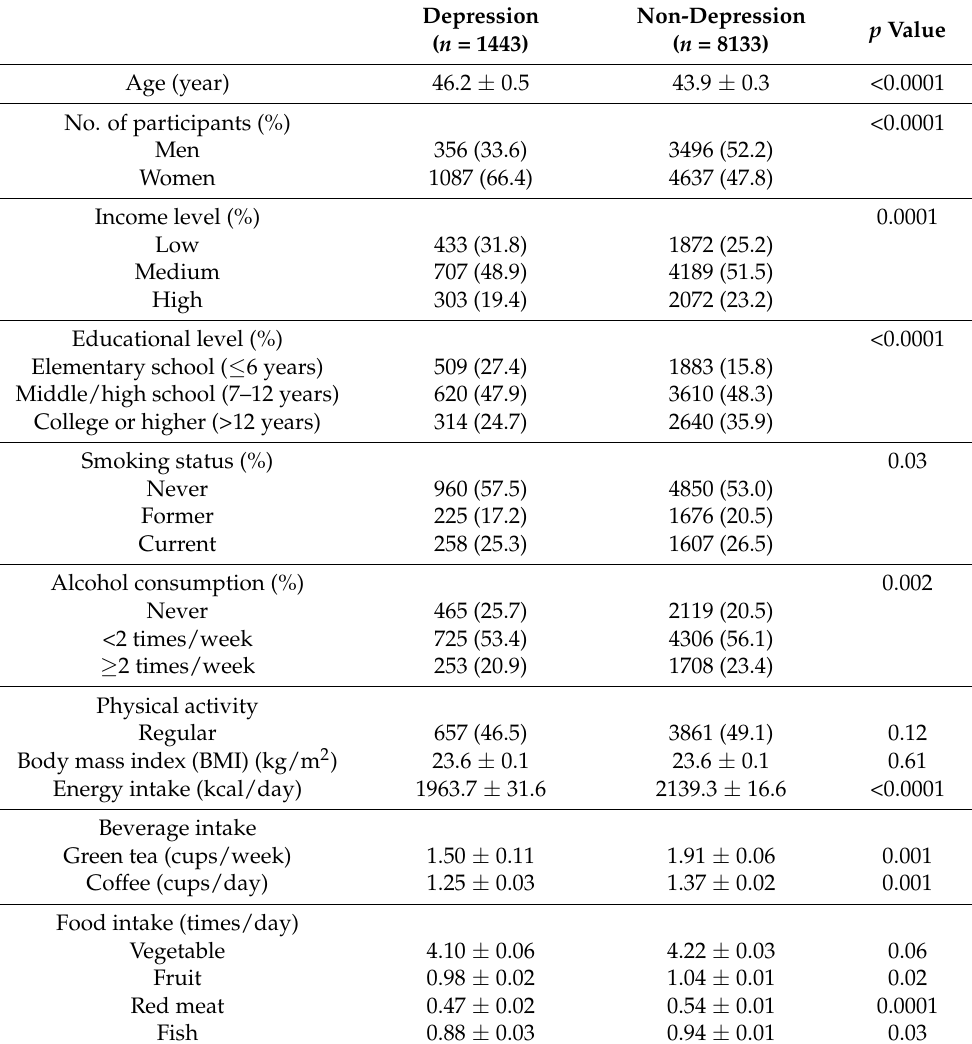
Table 1. Characteristics of participants by depression status ( n = 9576) a